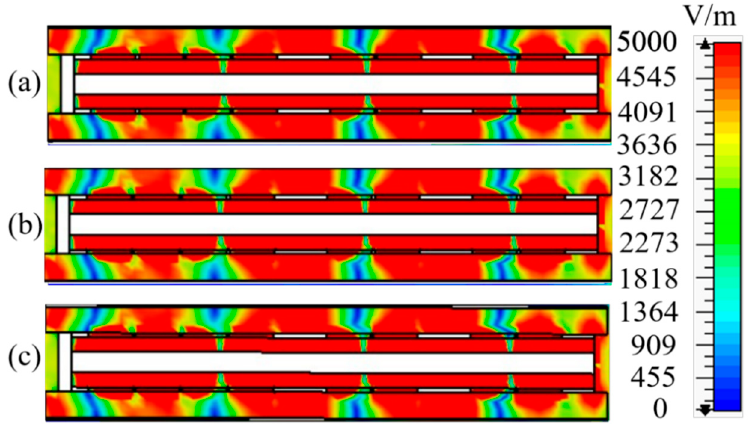
Figure 11. Electric field distributions at different plasma collision frequencies: ( a ) 2.8 × 10 8 Hz, ( b ) 3.0 × 10 8 Hz, and ( c ) 3.2 × 10 8 Hz. Table 4. Maximum and average values of the electric field at different plasma collision frequencies. Plasma Collision